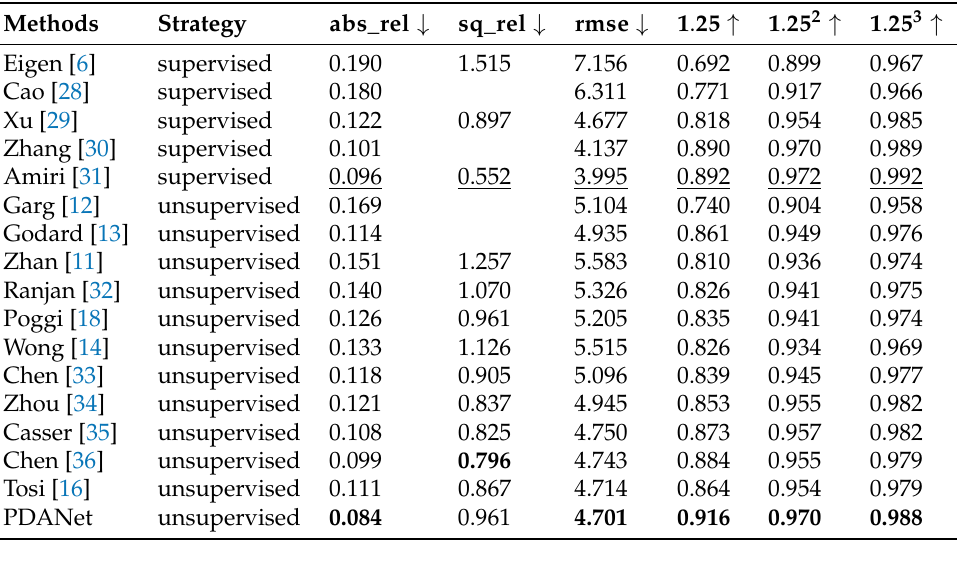
Table 3. Evaluation indicators for depth estimation models, where d ∗ presents the ground-truth depth, d denotes the predicted depth, and | D | is the number of predicted